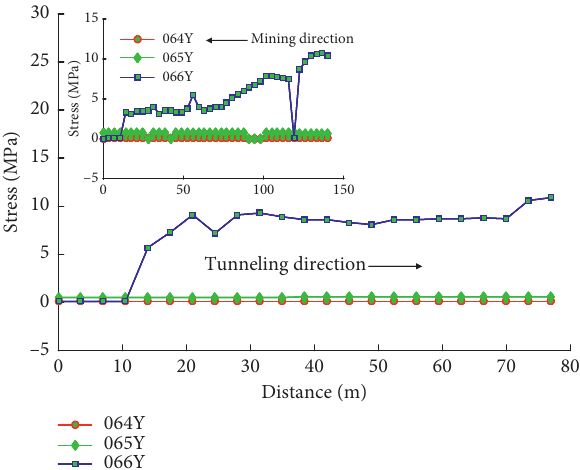
Figure 7: Changing rules of the coal